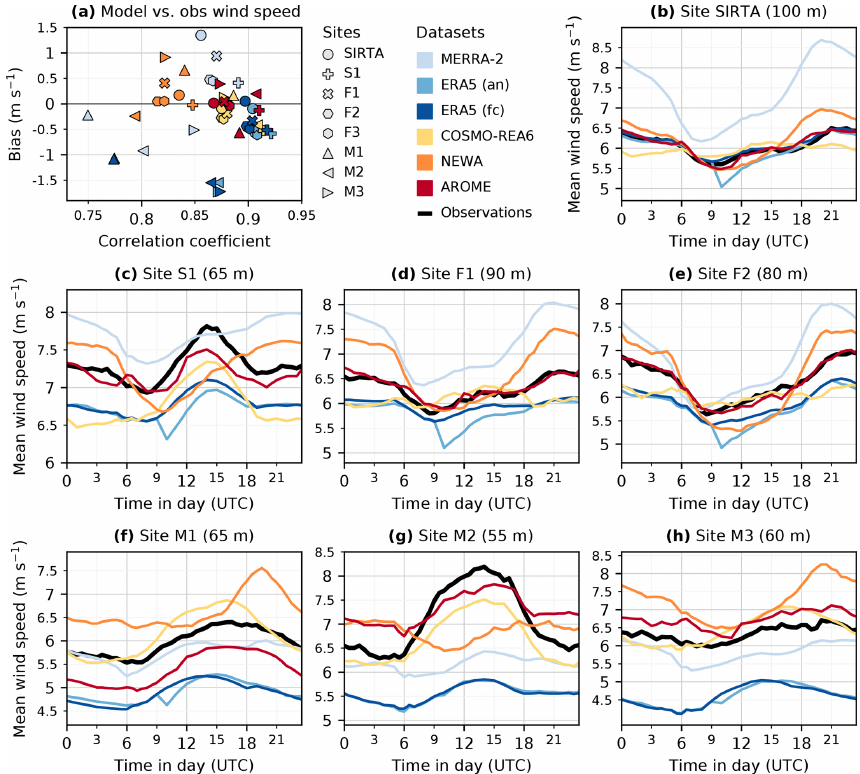
Figure 3. Comparison of modelled and measured wind speeds at 8 locations. (a) For each location (identified by marker style) and each model (identified by marker colour): bias (model – observation, on the y -axis) versus correlation coefficient (on the x -axis) of the 30min time series. The time period depends on the location: see Table 2. (b–h) Average diurnal cycles of the observed (in black) and modelled (in colours) wind speeds at all locations except F3 which is extremely similar to F2 (same time period and very close locations). See location characteristics in Table